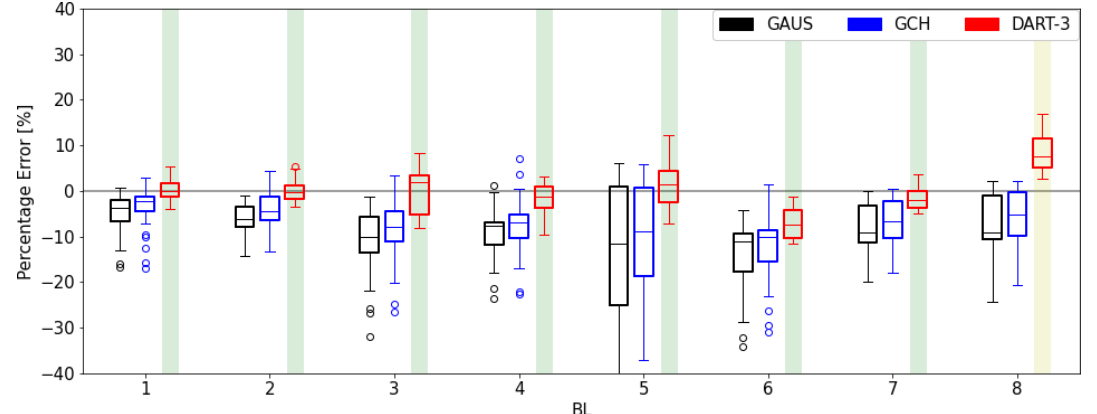
Figure 10. Same as Fig. 9, but for partial-wake operation, i.e., with a virtual downstream turbine moved 0.5D to the